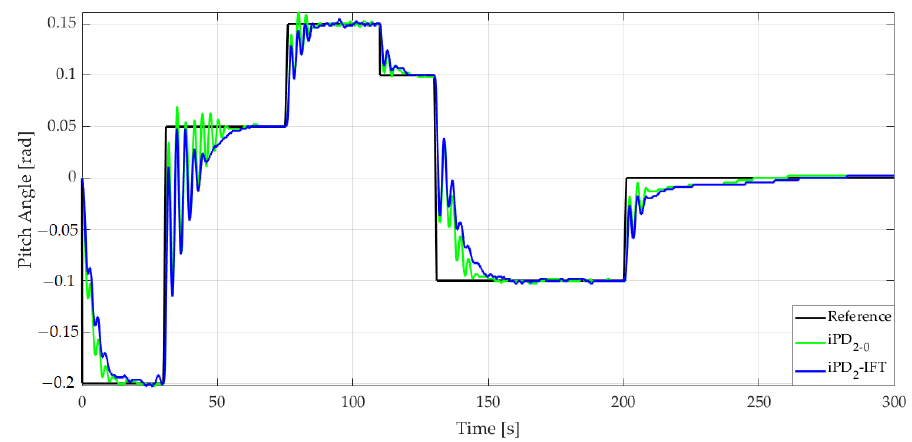
Figure 9. Comparison between the iPD 2-0 and iPD 2 -IFT controllers for the pitch angle variations.